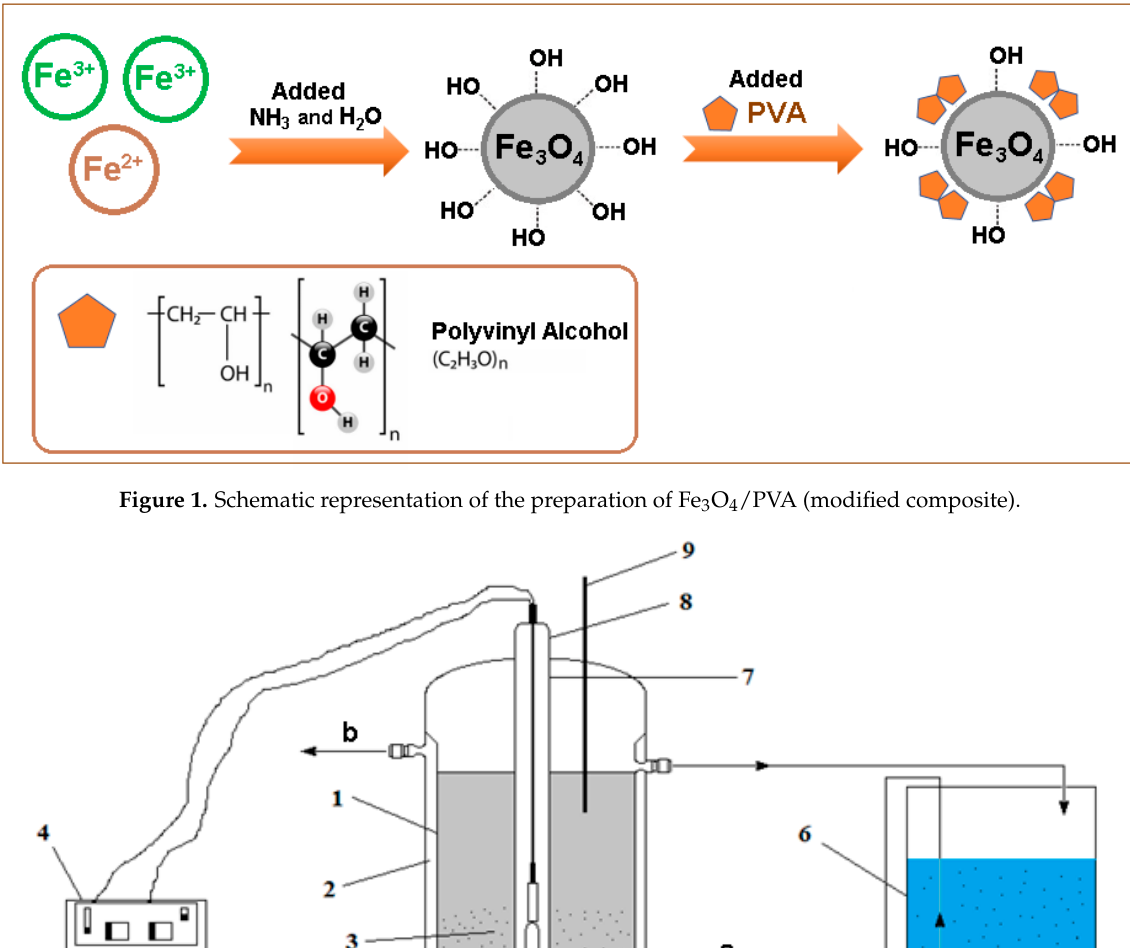
Figure 1. Schematic representation of the preparation of Fe 3 O 4 /PVA (modified composite).